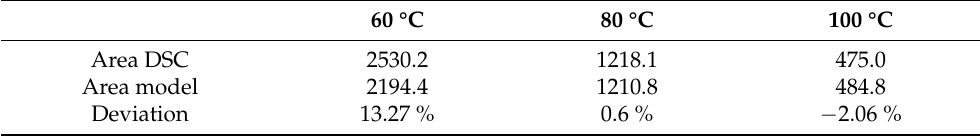
Table 2. Area difference between DSC measurement and Kamal-Sourour model predictions.